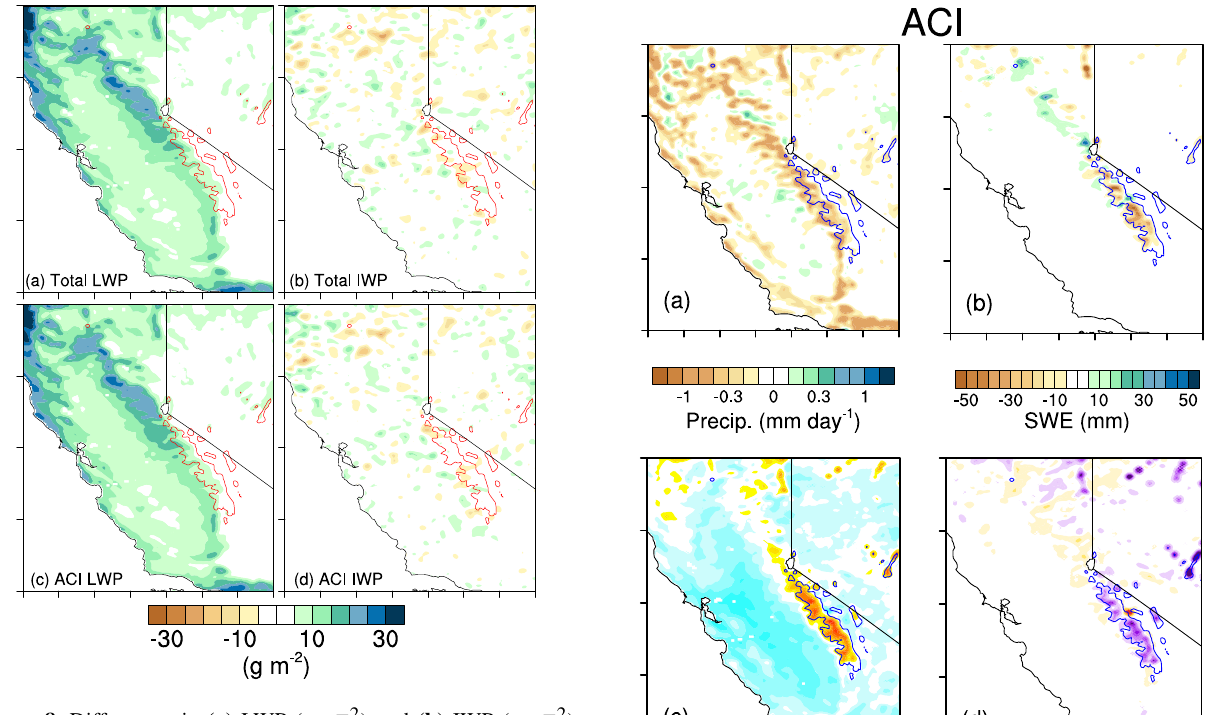
Figure 8. Differences in (a) LWP (gm − 2 ) and (b) IWP (gm − 2 ) due to all aerosol effects (CTRL – CLEAN), and (c) LWP (gm − 2 ) and (d) IWP (gm − 2 ) due to the ACI effect (NARS – CLEAN). Red lines represent the mountaintops with elevation ≥ 2.5km.